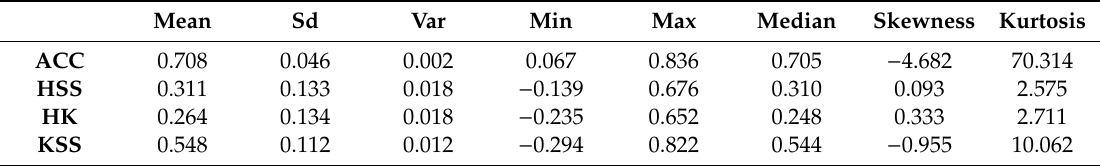
Table 6. Statistics for the scores of the Artificial Neural Network (ANN) method (training data set).